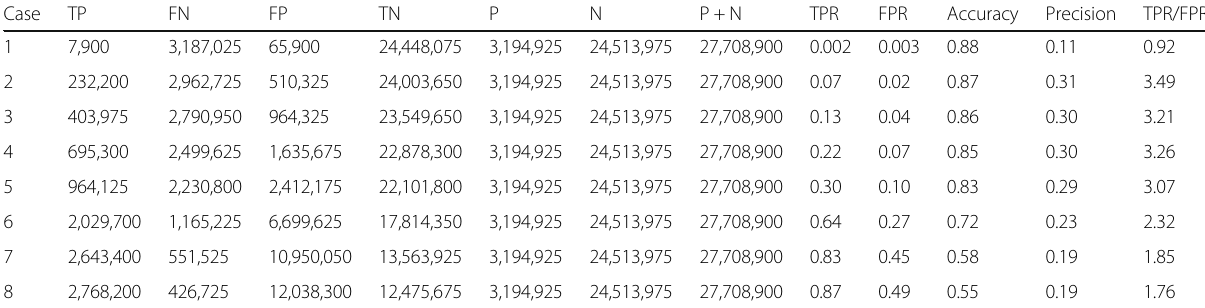
Table 6 Calculation results of eight cases with or without seismic loading